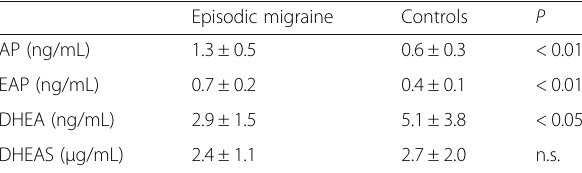
Table 2 Plasma neurosteroid levels in patients affected by episodic migraine patients and healthy controls